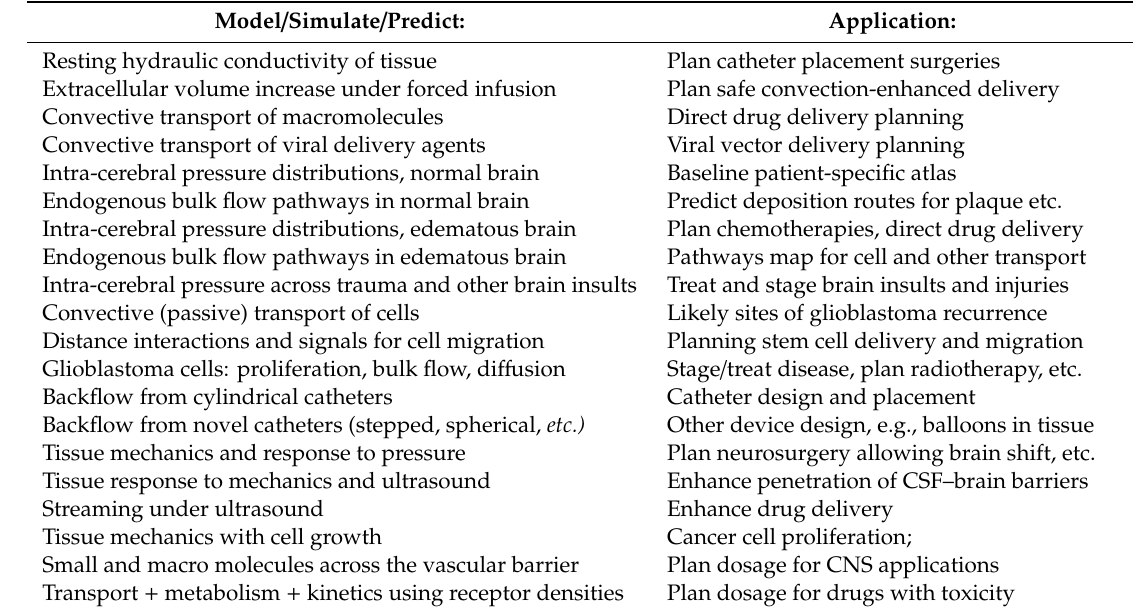
Table A2. Potential uses of